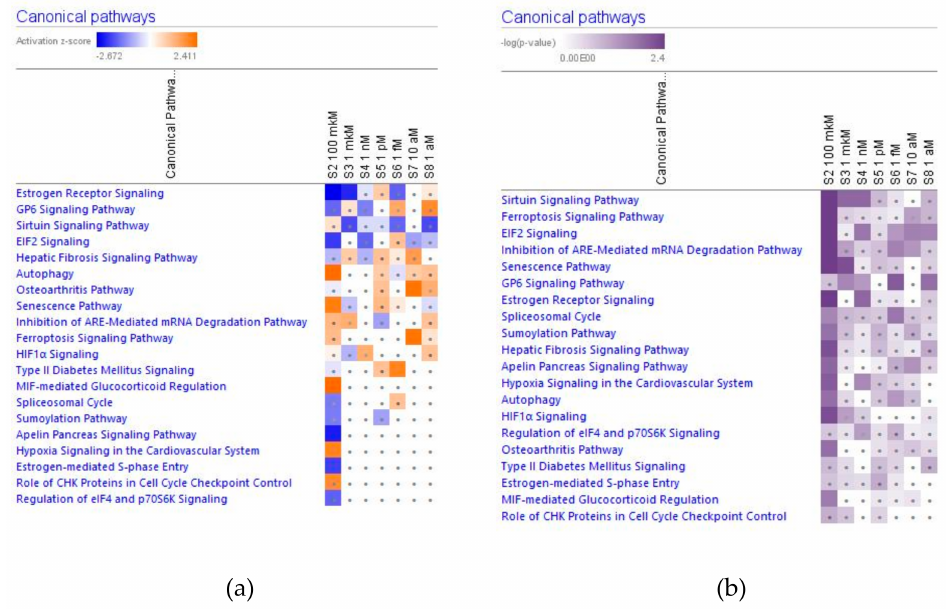
Figure 4. Effect of Rg5 in concentrations of 1 aM, 10 aM, 1 fM, 1 pM, 1 nM, 1 µ M and 100 µ M) on nuclear receptors and transcriptional regulation (including estrogen receptors and sirtuin) signaling. ( a ) The brown color depicts predicted activation, blue color—predicted inhibition of signaling pathway; the symbol shows that the activation z-score was <2. ( b ) The symbol shows that the − log p -value was